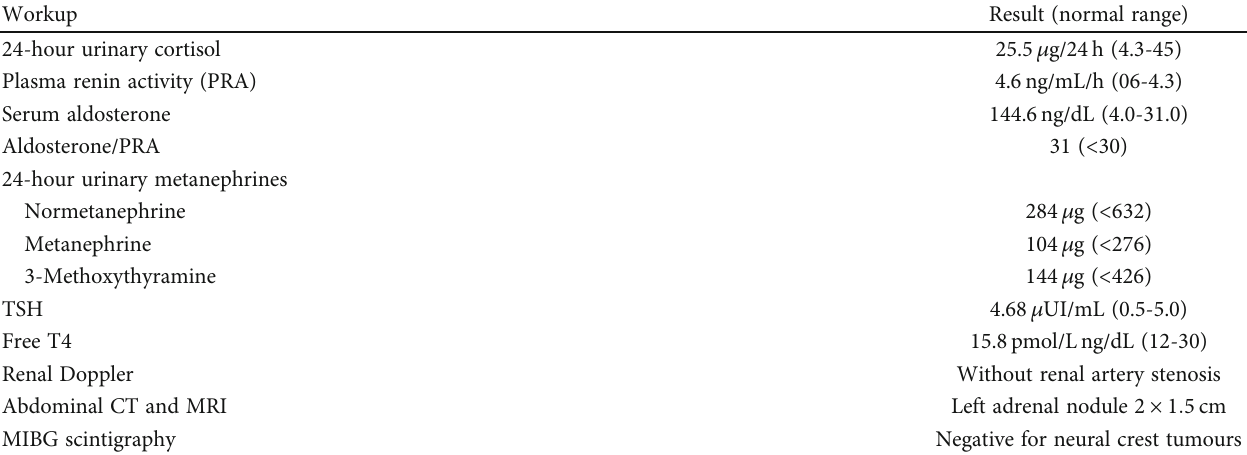
Figure 2: Blood pressure evolution. MTH-EAR: months earlier; Disch: discharge; MTH-FW: months follow-up; SBP: systolic blood pressure; DBP: diastolic blood pressure. Blood pressure values presented as mmHg. Table 2: Secondary hypertension